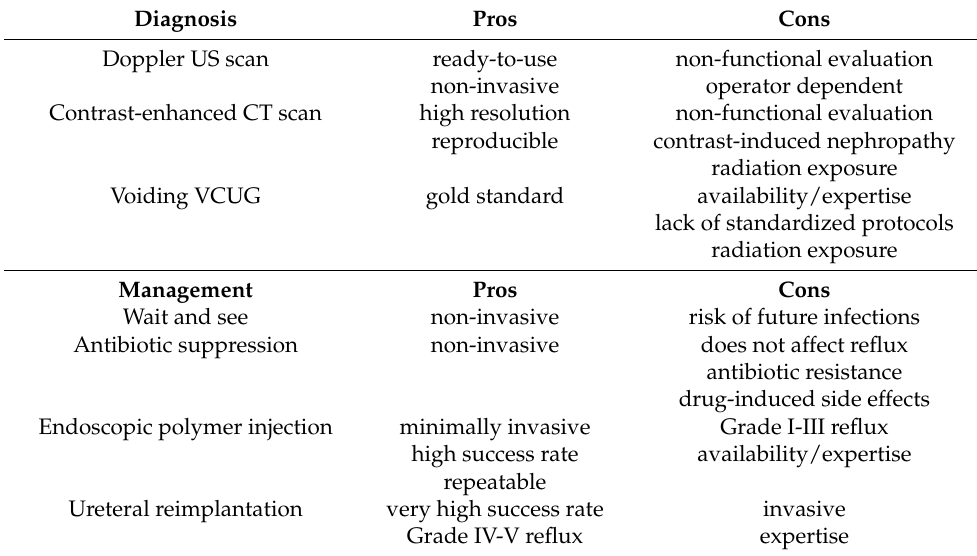
Table 2. Diagnosis and management of post-transplant vesicoureteral